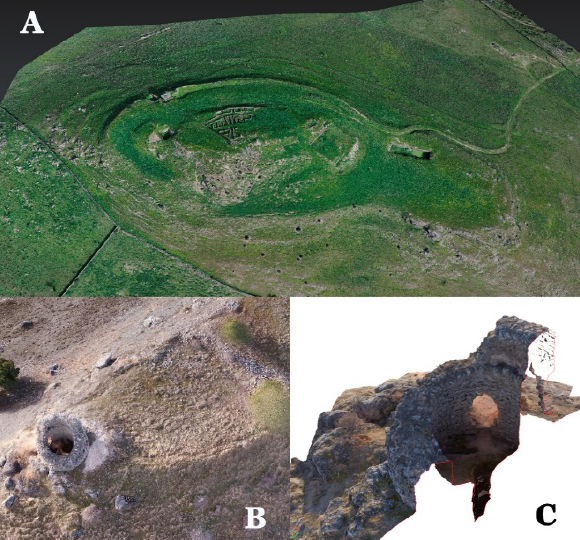
Figure 1. A. 3D model made with RPAS/drone of Hornachuelos Iron Age hillfort (17 hectares, Spain); B. 3D model of a medieval tower (Membrillera, Spain), made with a drone and compact camera to document the interior and underground parts; C. Cross-section over a 3D model of Membrillera tower.